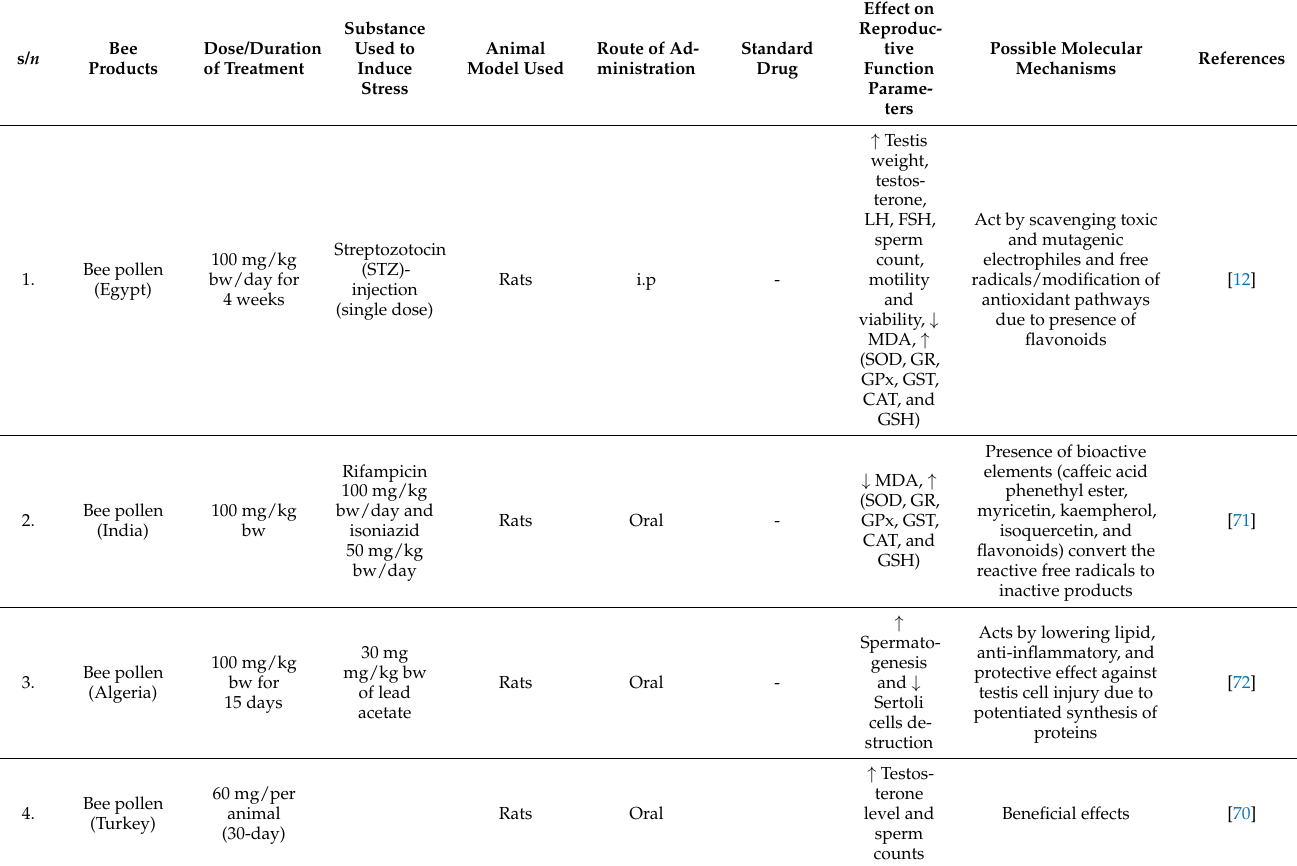
Table 1. Effects of bee products on male reproductive